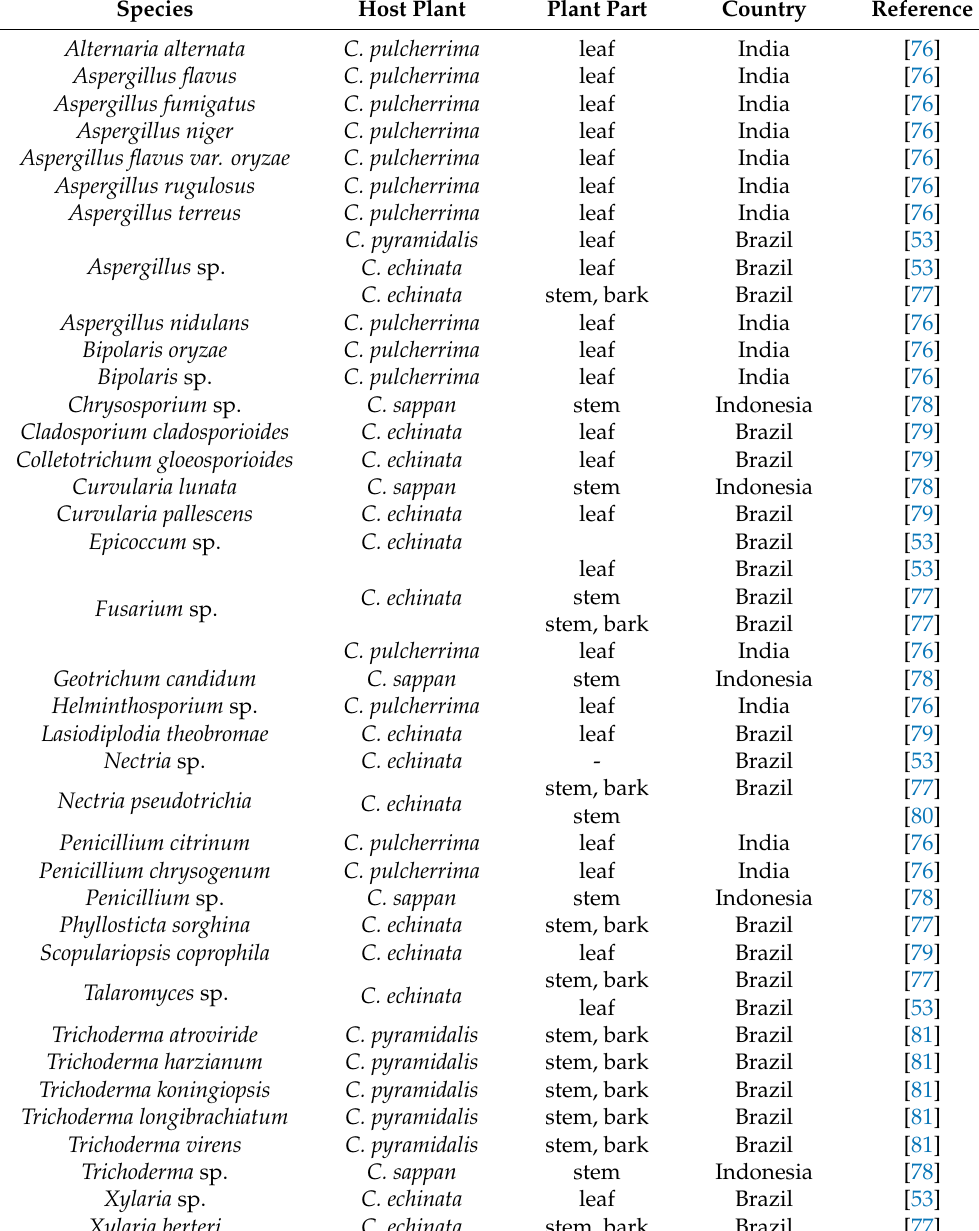
Table 6. Endophytic fungi isolated from Caesalpinia